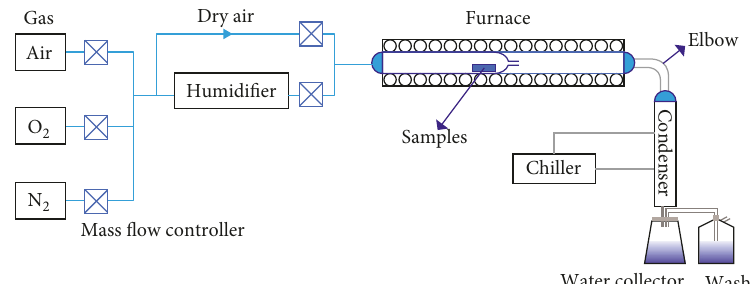
Figure 4: Schematic of Cr evaporation test units at University of Connecticut.